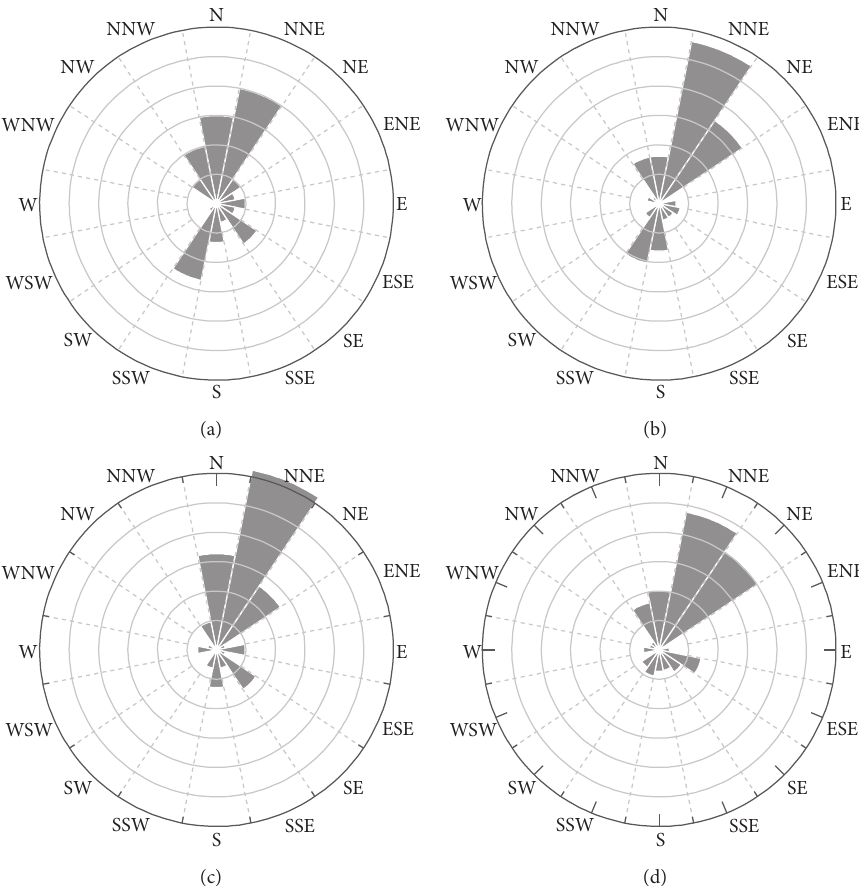
Figure 5: A wind-rose diagram for each season in Wuhan. (a) Spring. (b) Summer. (c) Autumn. (d)